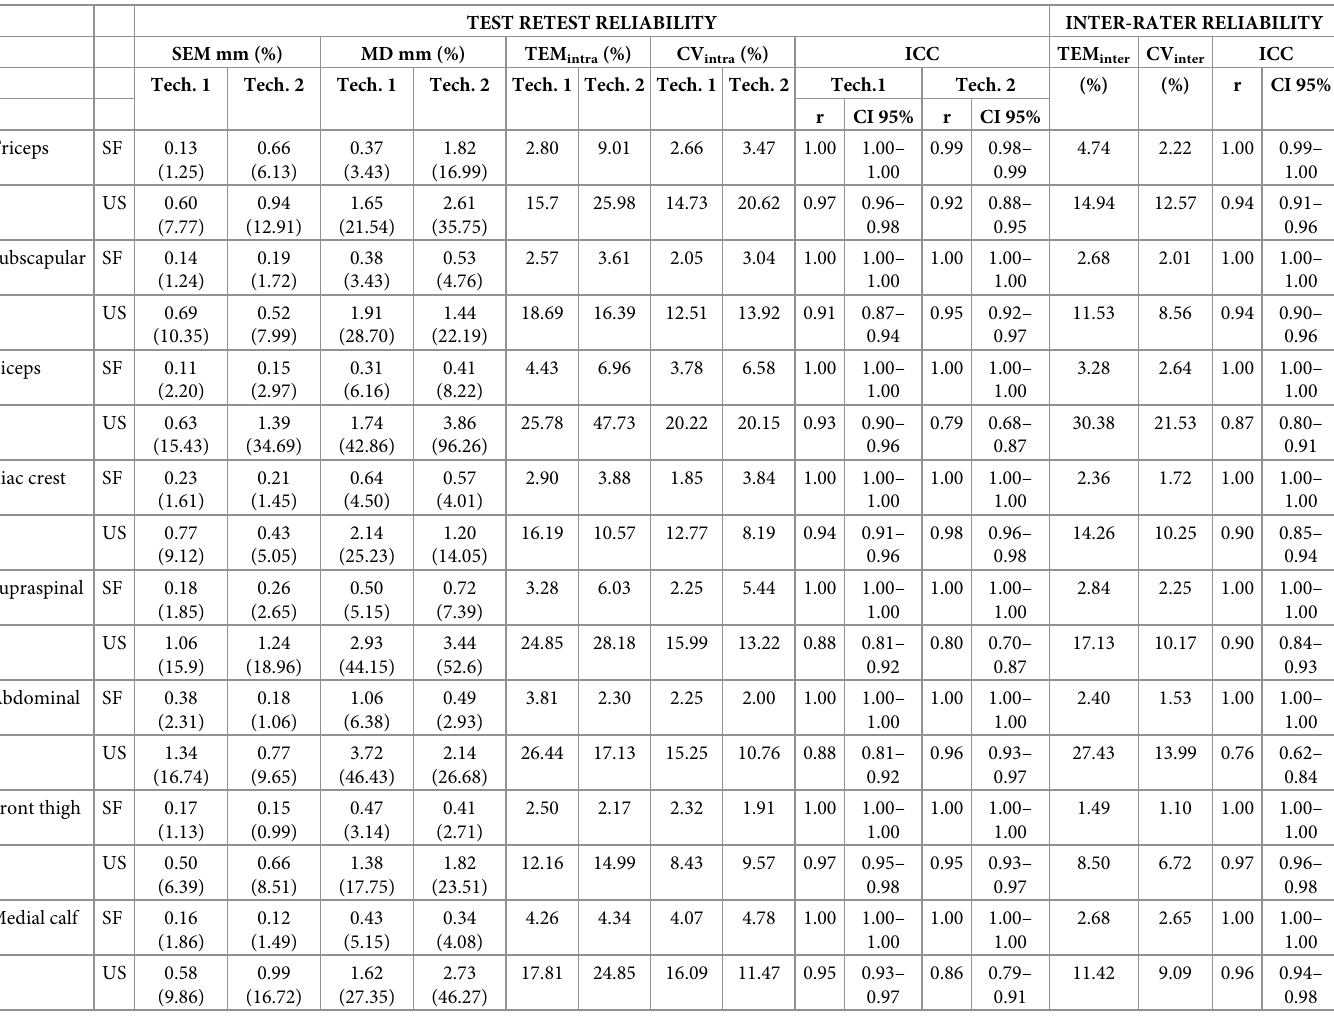
Table 2. Reliability statistics for eight anatomical sites assessed with skinfolds and ultrasound